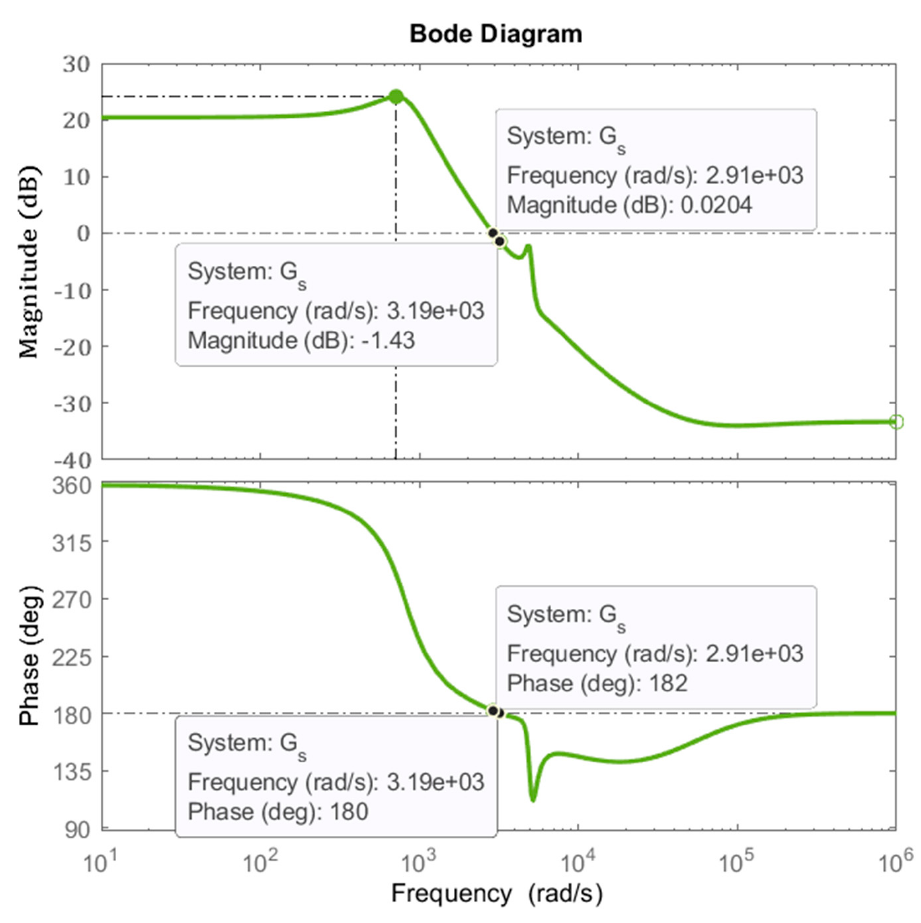
Figure 10. Bode plot for the SCZEBC converter.